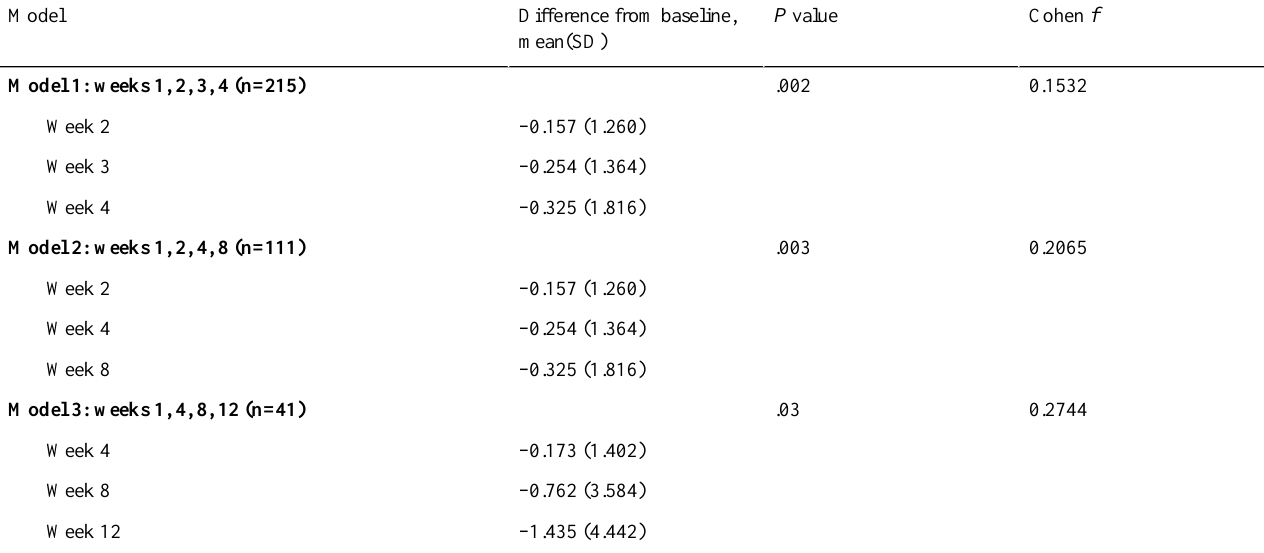
Table 2. Differences in waist circumference using repeated ANOVA for three models. a